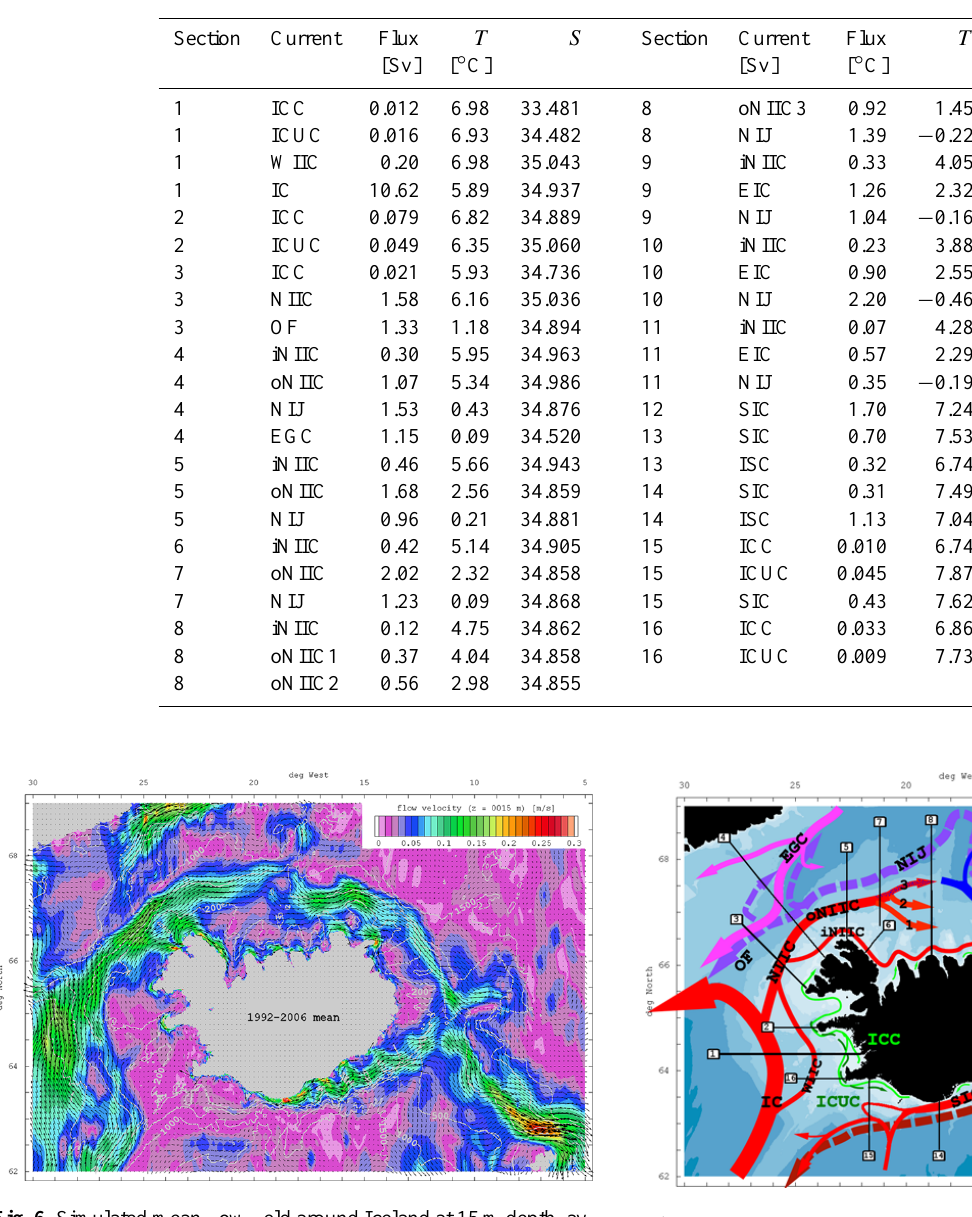
Table 2. Simulated 1992–2006 mean volume flux, temperature and salinity of the currents in Icelandic waters across the 16 analysis sections. See Figure 7 for the locations of the sections and for the abbreviations of ocean current names.